Question: Describe this figure in one sentence.
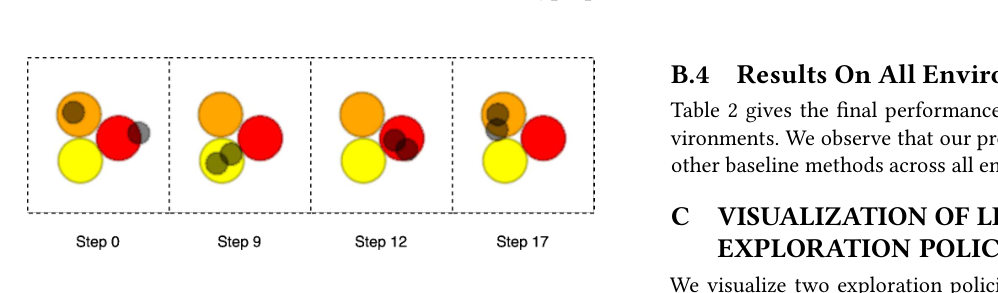
Answer: Visualization of two learned exploration policies in 2-agent 3-landmark MPE tasks. The ﬁgure shows the critical steps in the trajectory where agents coordinately reach high- rewarding states that were previously collected.